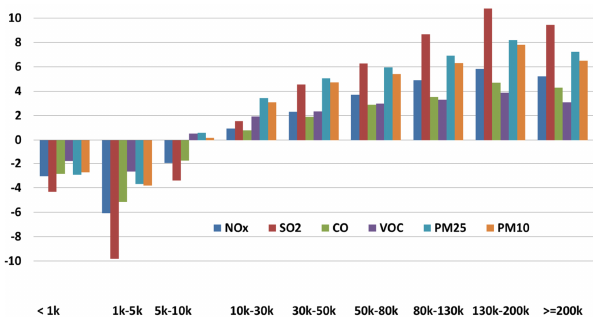
Figure 10. MFD (%) of 2050 annual emissions, Future minus Fu- tureRegGF , stratified by grid-cell population for 2050. ( Future : 2050 inventory, 2050 surrogates, county growth factors; Futur- eRegGF : 2050 inventory, 2050 surrogates, regional growth factors).